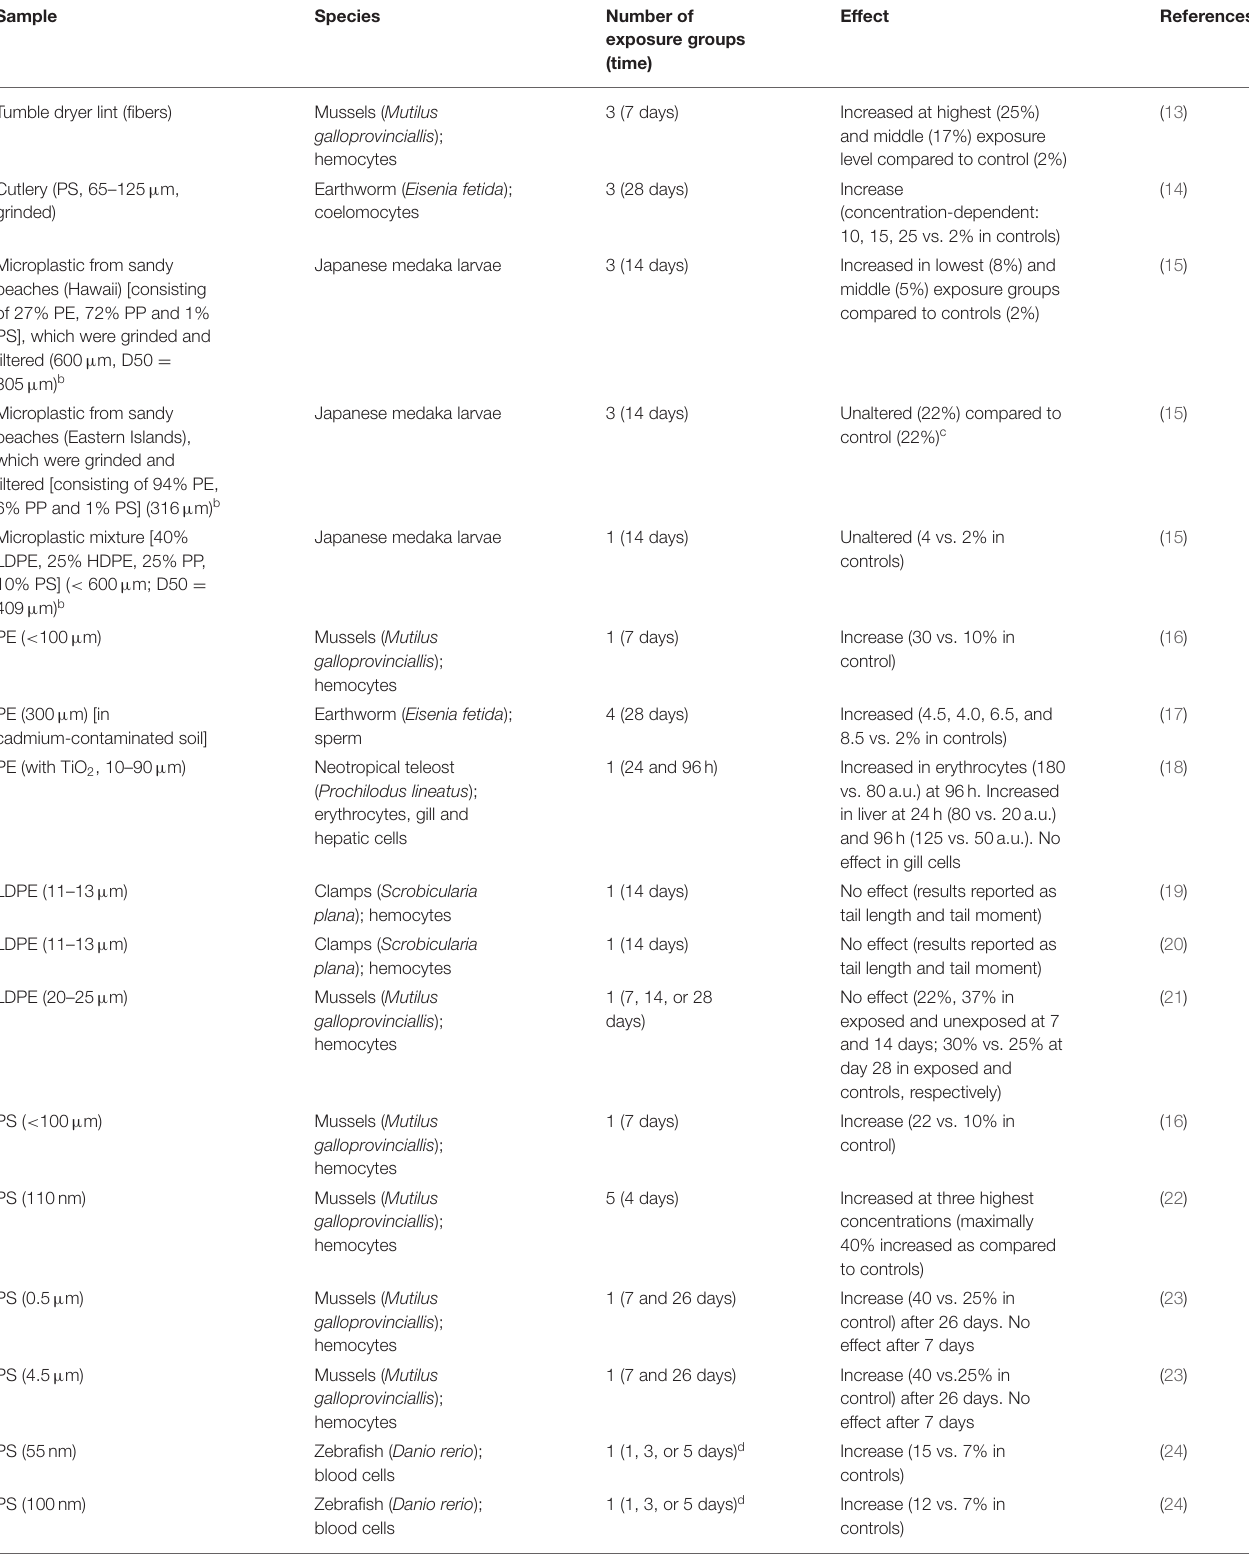
TABLE 1 | DNA damage measured by the comet assay in marine or terrestrial species after exposure to plastic particles a .